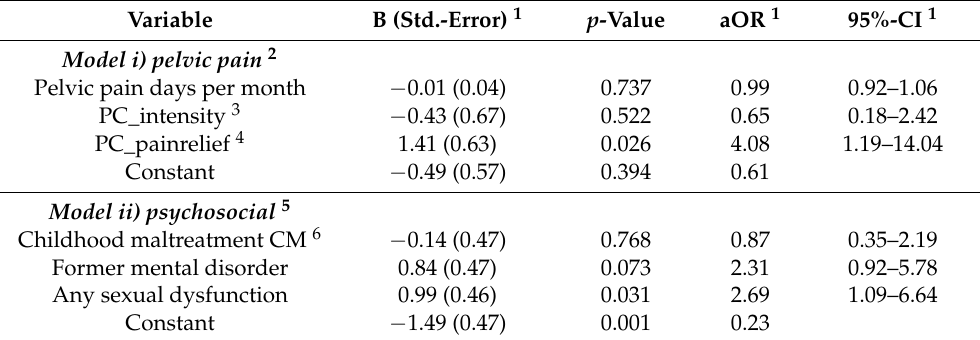
Table 3. Results of the binary-logistic regression analyses for the cross-sectional prediction of a current comorbid mental disorder in the total sample including (i) pelvic-pain-related predictor variables or (ii) psychosocial predictor variables.